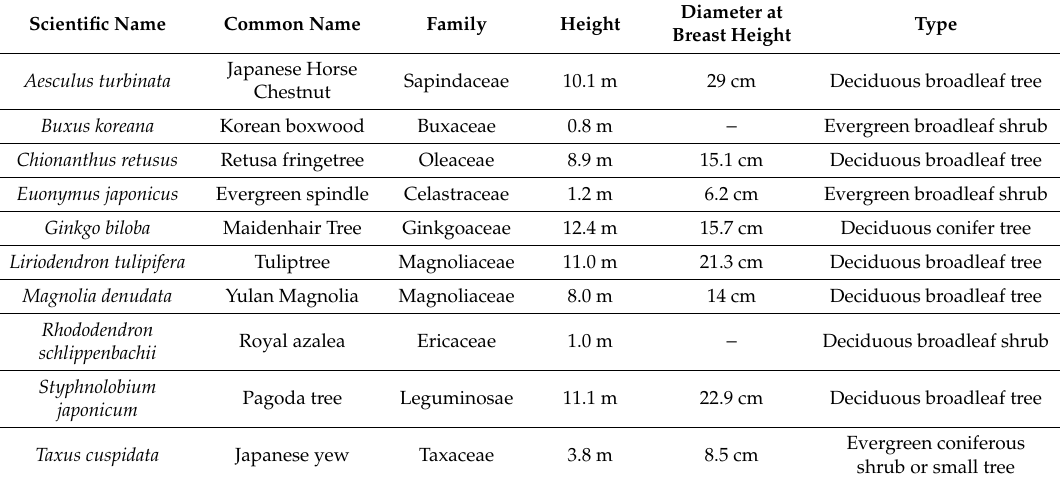
Table 1. List of ten major species ( n = 50) sampled at the Seoul Forest Park in Seoul, Korea with scientific name, common name, family, height, and type (Quoted from: Korea National